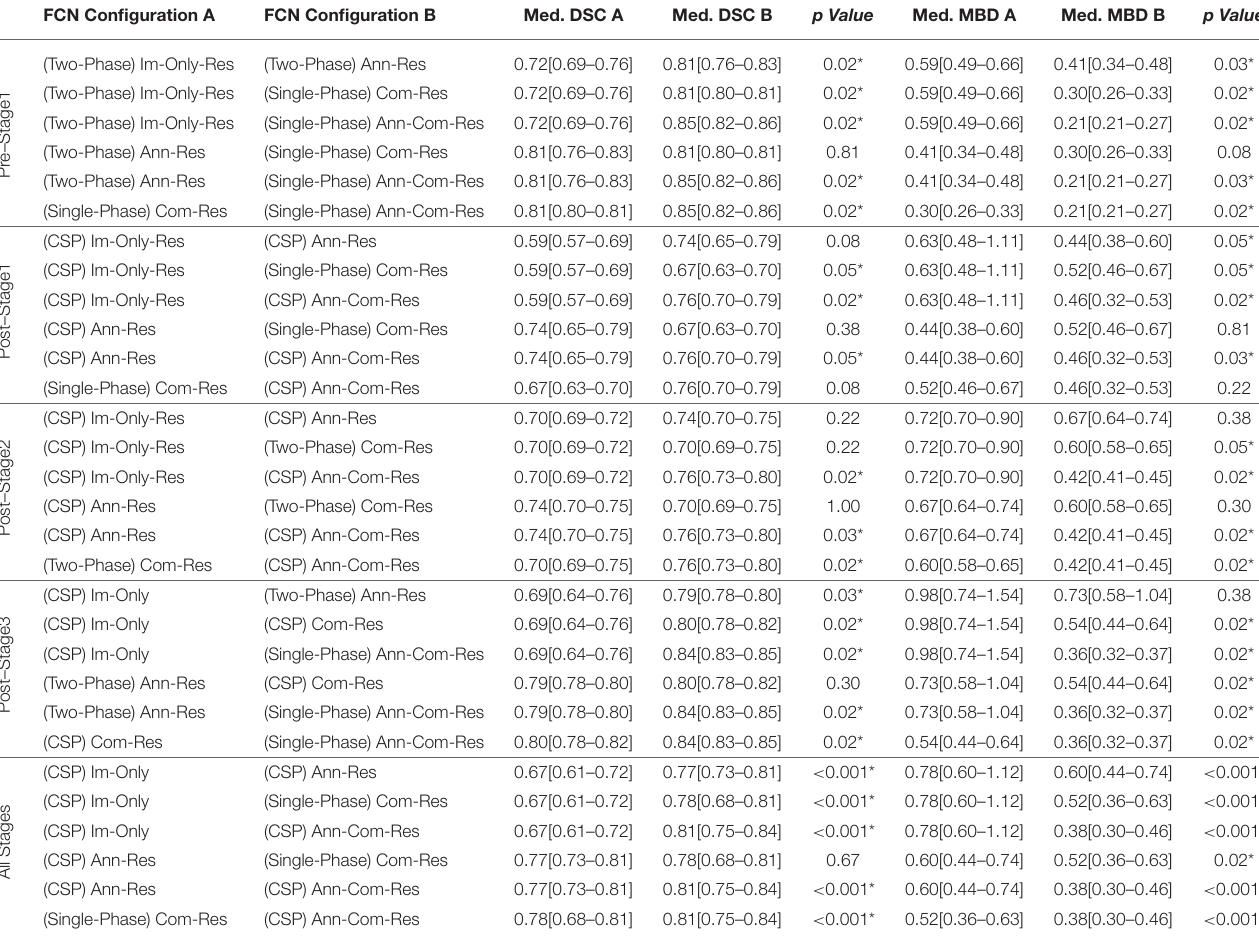
TABLE 7 | Median DSC and MBD of the average across leaflets, and p values for two–sided non–parametric Wilcoxon signed–rank test at individual stages and all stages combined. FCN Configuration A